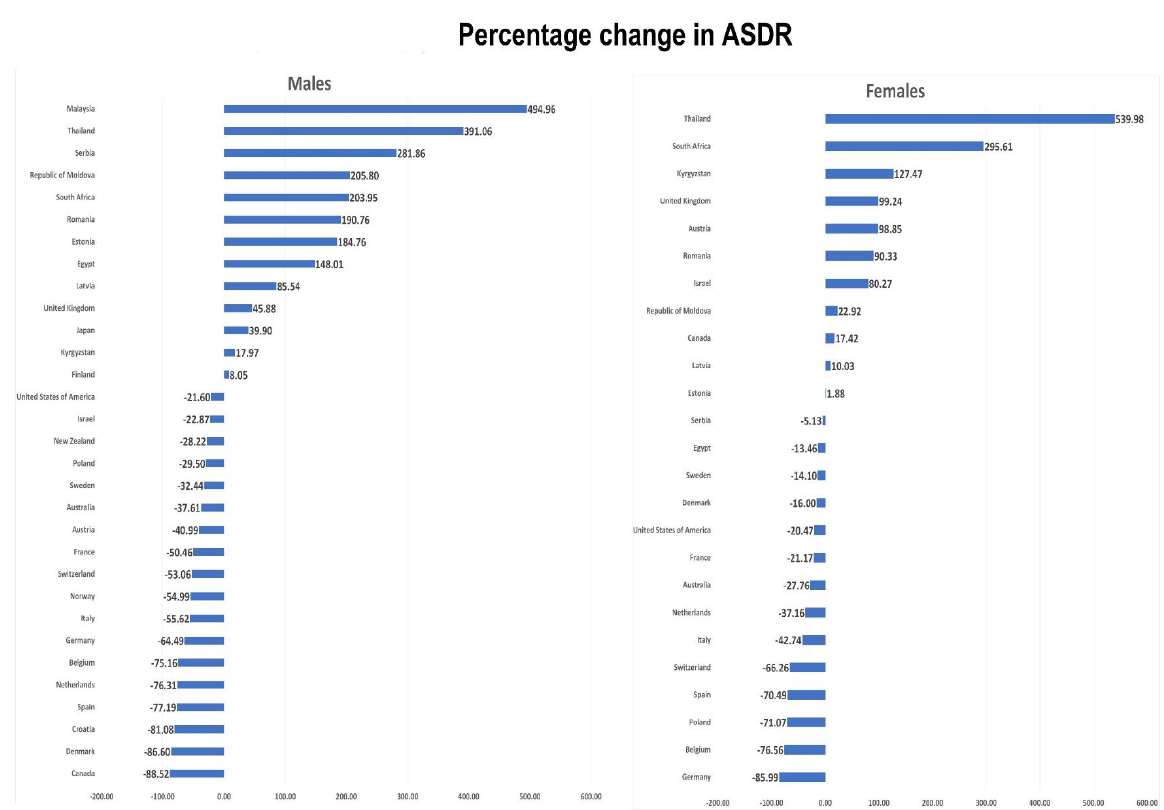
Figure 3. Percentage changes in Age-Standardized Death Rate in males and females between the end and start point of the study. End point for Canada: 2005, USA: 2007, rest of the countries end point varies between 2013 – 2018.